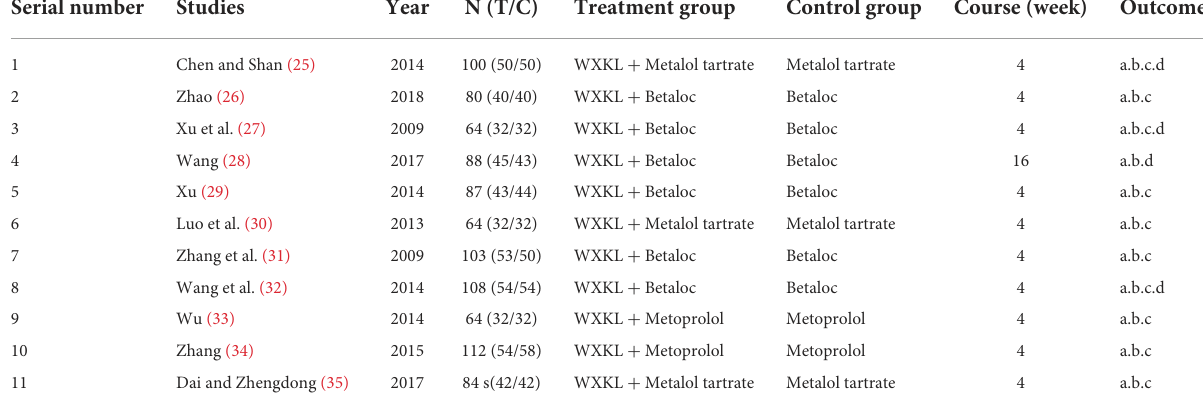
TABLE 2 The details of the included studies.